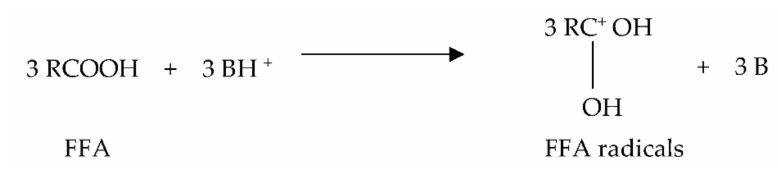
Figure 5. A schematic representation of the glycerolysis reaction second step.